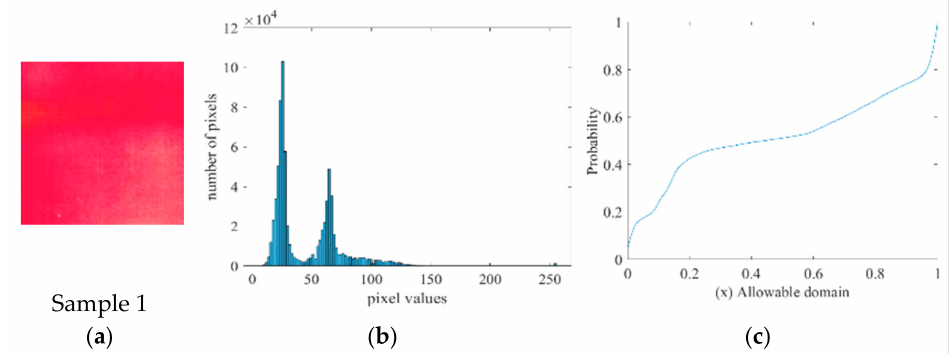
Figure 2. ( a ) Thermal solar cell image; ( b ) corresponding histogram; ( c ) corresponding CDF.